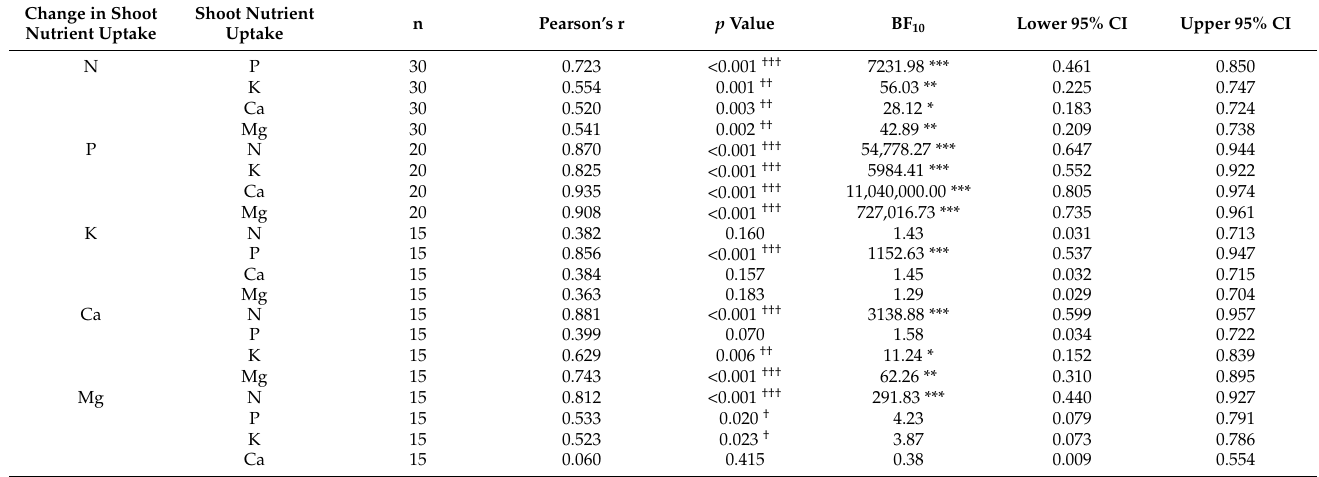
Table 4. Bayesian Pearson’s correlations among N, P, K, Ca, and Mg uptake in shoot of potato plants as affected by individual nutrient concentrations in MS medium in